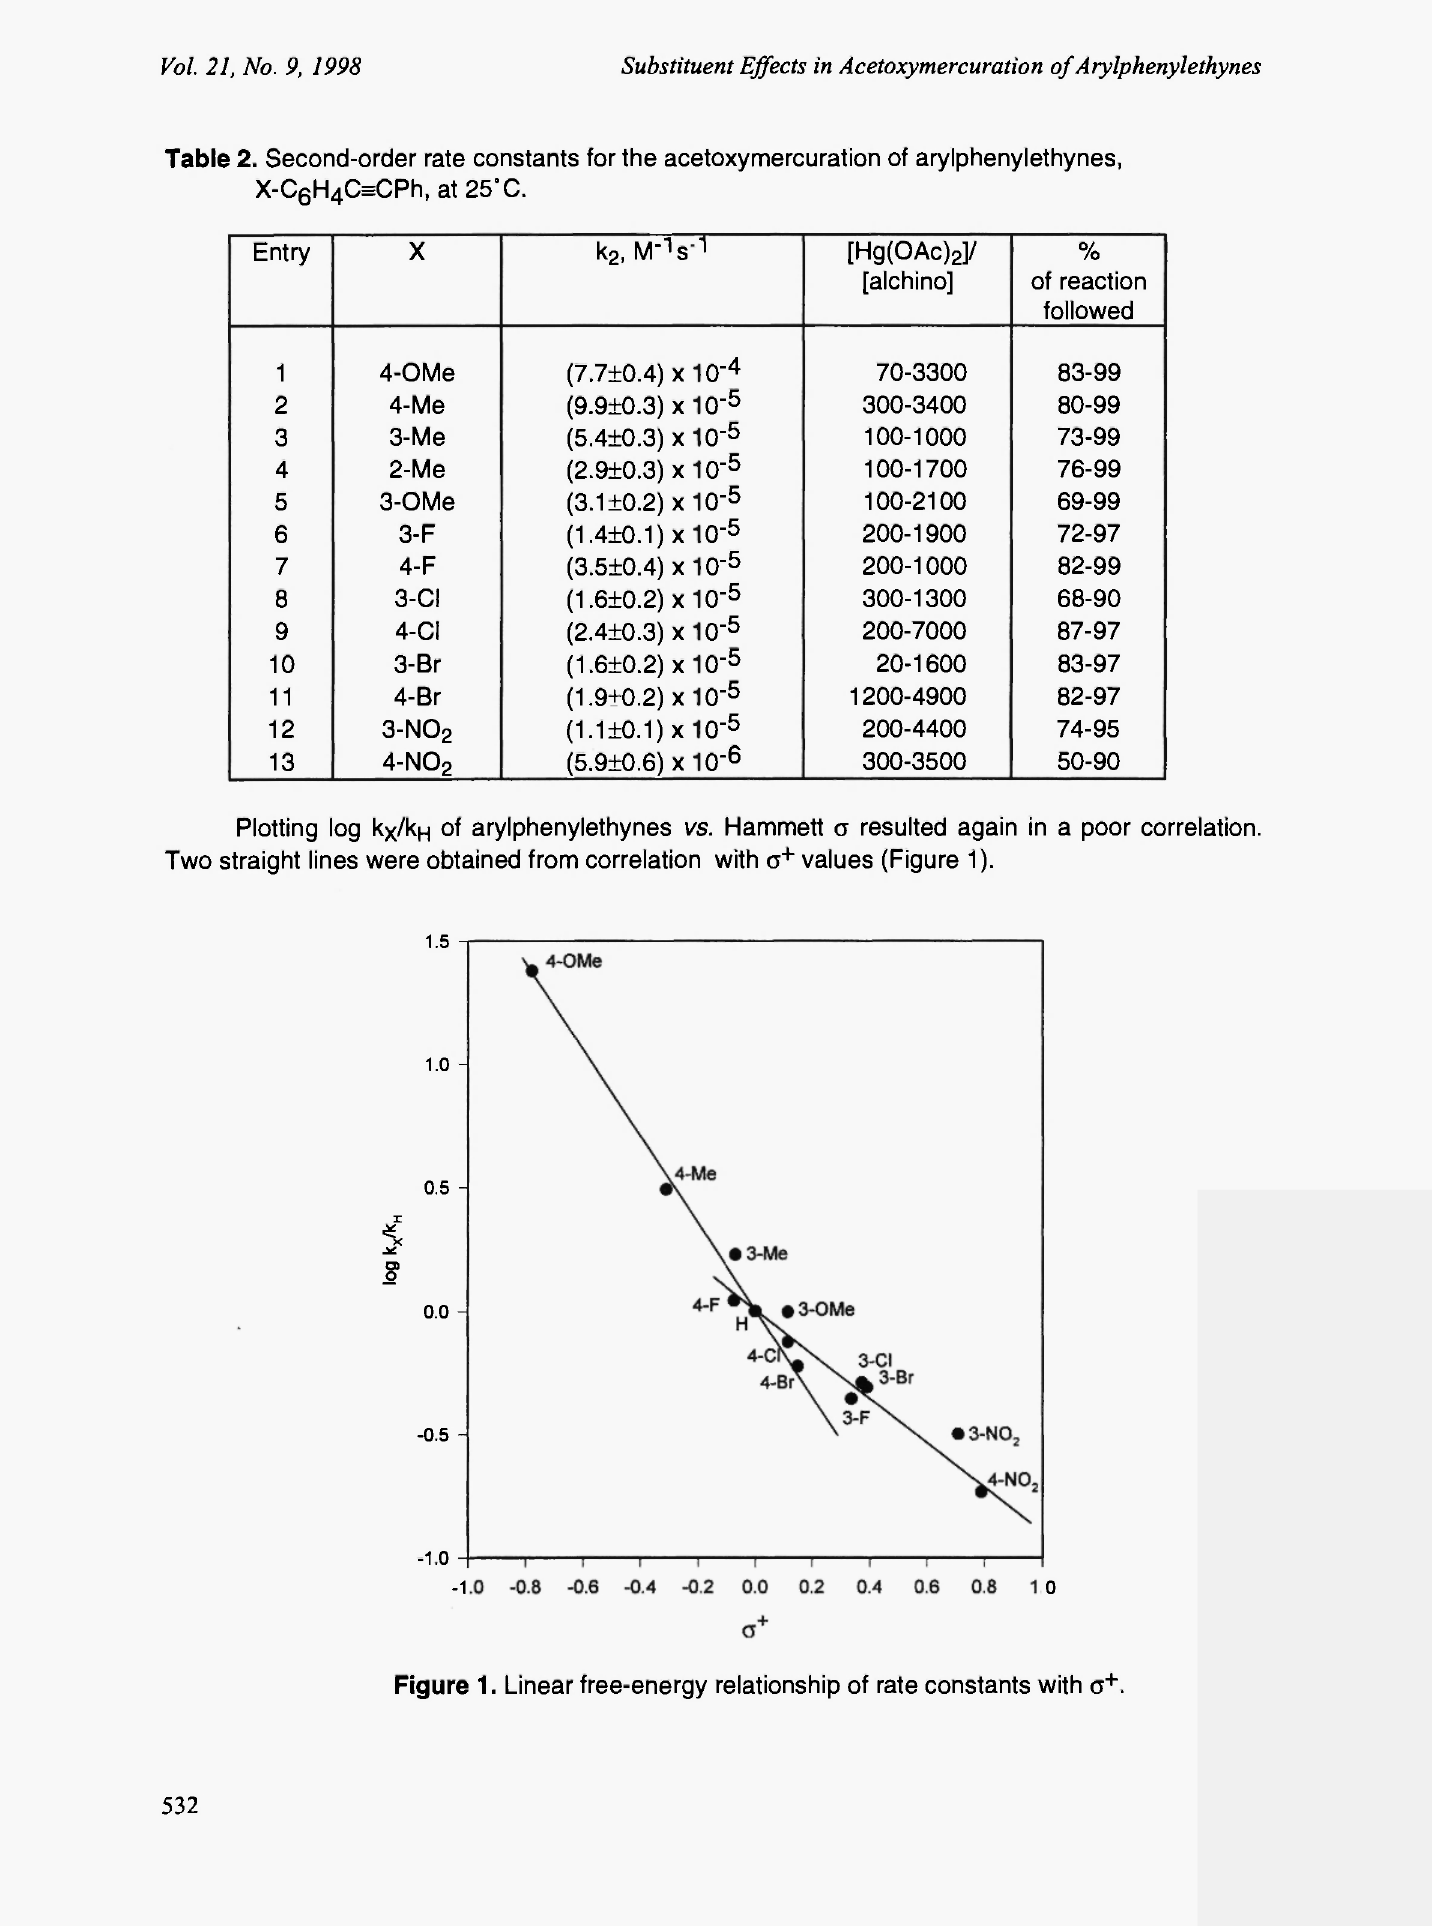
Table 2. Second-order rate constants for the acetoxymercuration of arylphenylethynes, X-C 6 H 4 CsCPh, at25°C.